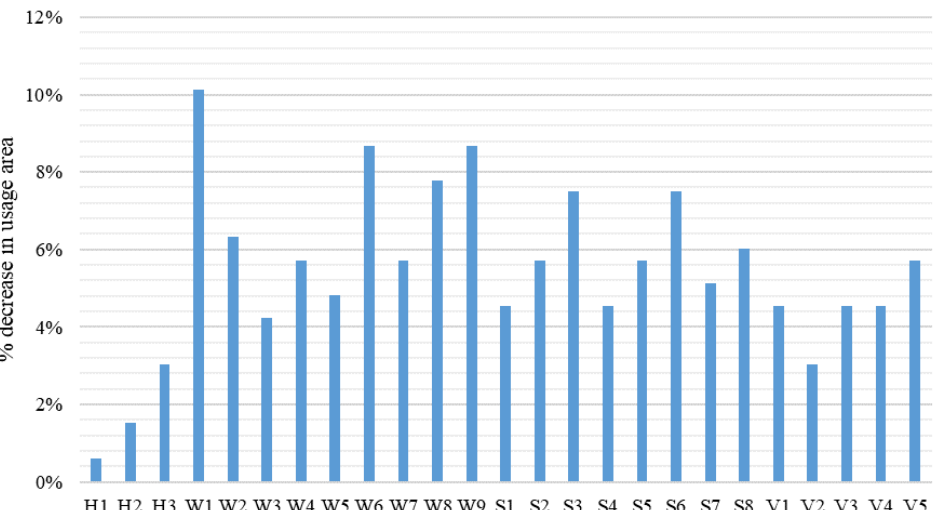
Figure 6. The percent decrease in used area with changes in wall thickness cases.